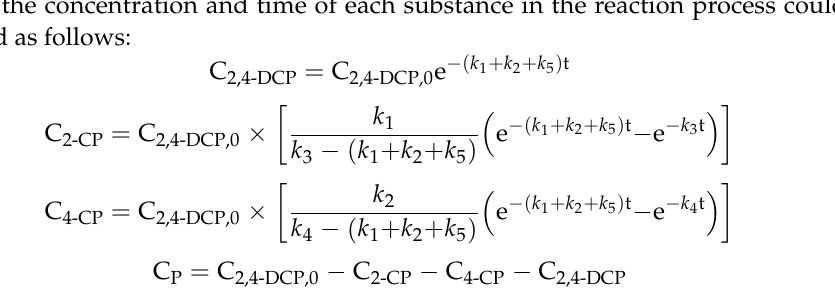
Figure 6. Reaction pathways for 2,4-DCP dichlorination by D-ATP-nFe/Ni.